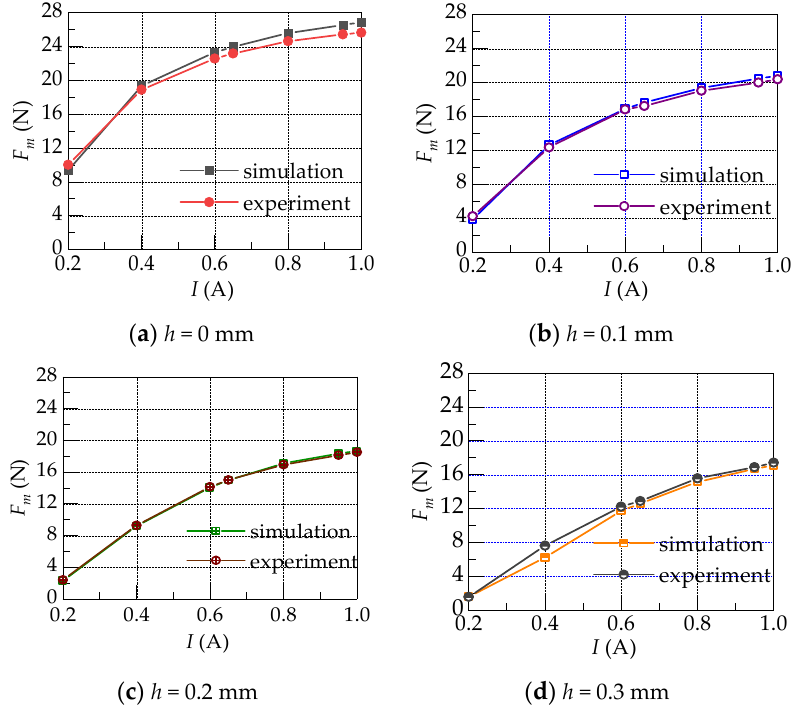
Figure 8. Test and simulation results of the static electromagnetic force along with the coil exciting current under different air gaps.